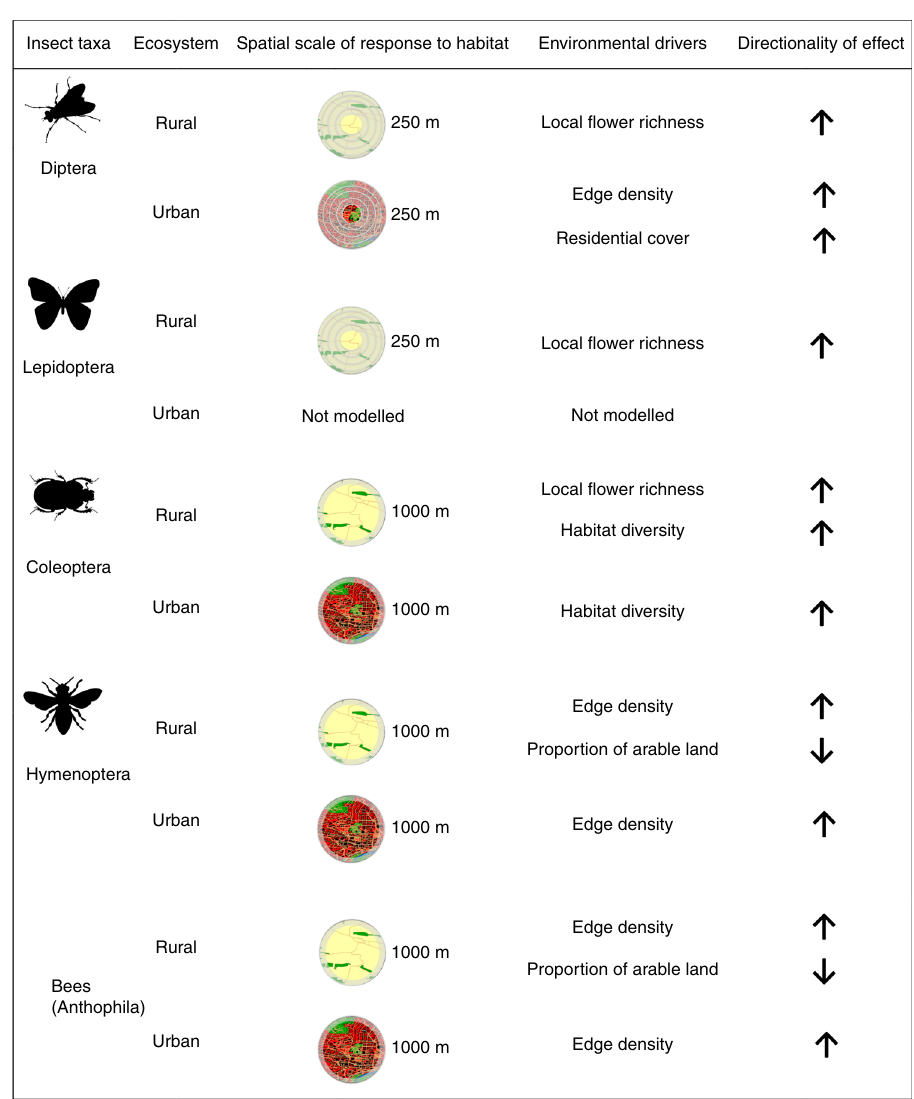
Fig. 3 Environmental drivers of insect OTU richness in rural and urban ecosystems. Signi fi cant (GLM; P < 0.05) environmental drivers of OTU richness of Diptera, Lepidoptera, Coleoptera, Hymenoptera and bees (Anthophila, a subset of Hymenoptera) in N = 9 rural and N = 9 urban sites at the local patch and landscape scales (1000 m radius for all Hymenoptera and Coleoptera, 250m for all Diptera and Lepidoptera). Due to low sample size (mean = 1.44 ± 1.01 SD), Lepidoptera OTU richness was not modelled within urban sites. We did not fi nd any signi fi cant predictors of hover fl ies (Syrphidae) OTU richness in rural or urban ecosystems. Up-arrows and down-arrows correspond to positive and negative effects, respectively. Insect silhouettes courtesy of OpenClipart-Vectors/Pixabay, Elias Schäfer/Pixabay and Clker-Free-Vector-Images/